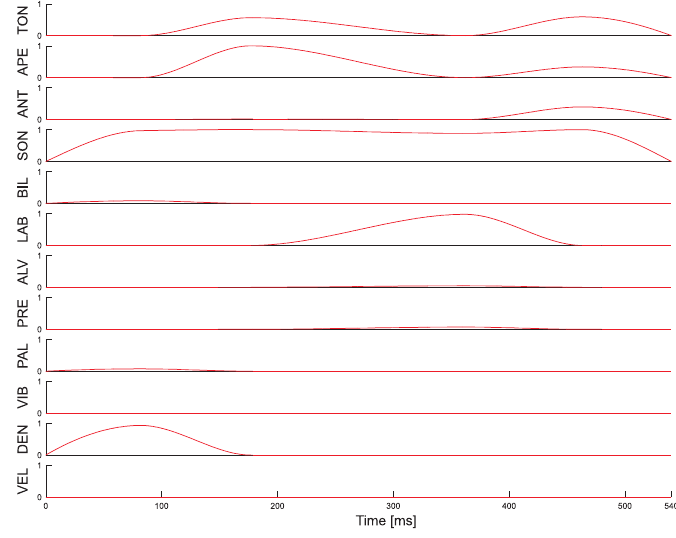
Figure 19. Articulatory places of articulation of the Italian word